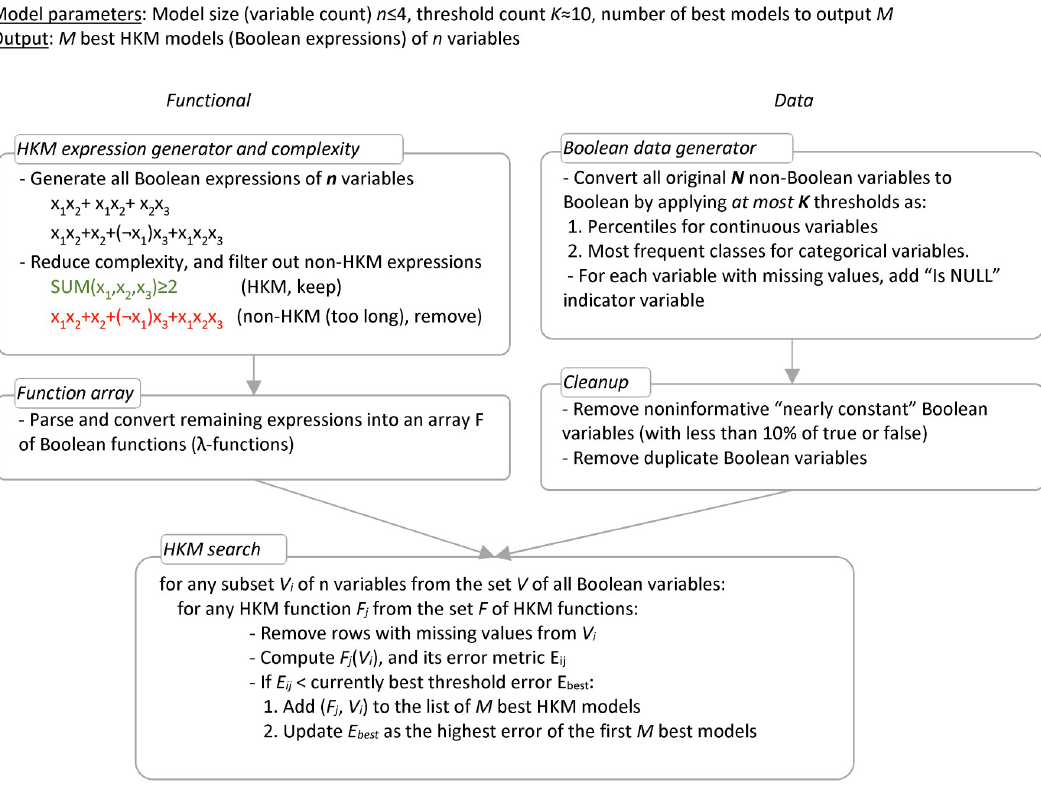
PLOS ONE | https://doi.org/10.1371/journal.pone.0275814 October 20,